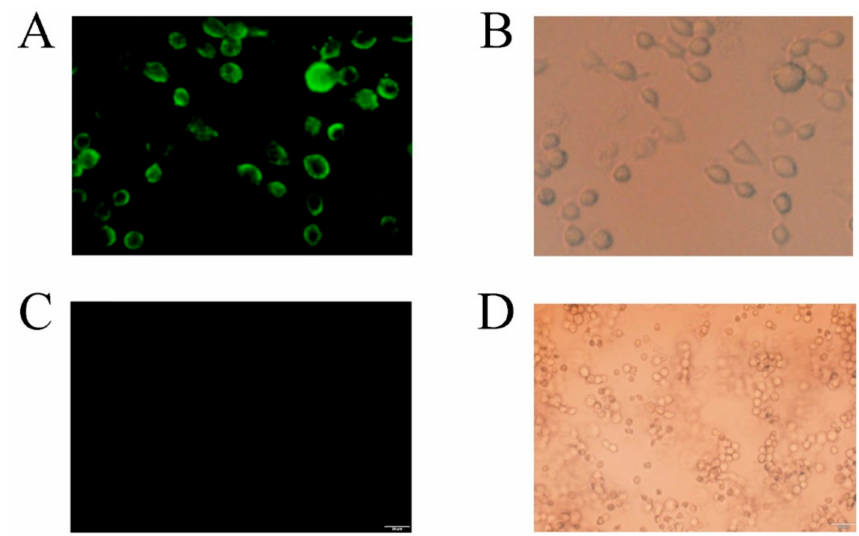
Figure 9. Laser confocal analysis of recombinant cells (displayed CDA) and control cells. Recombinant cells (displayed CDA): ( A ) the excitation source was turned on. Fluorescent cells indicate that CDA was successfully surface displayed on yeast; ( B ) the natural light source was turned on. Control cells: